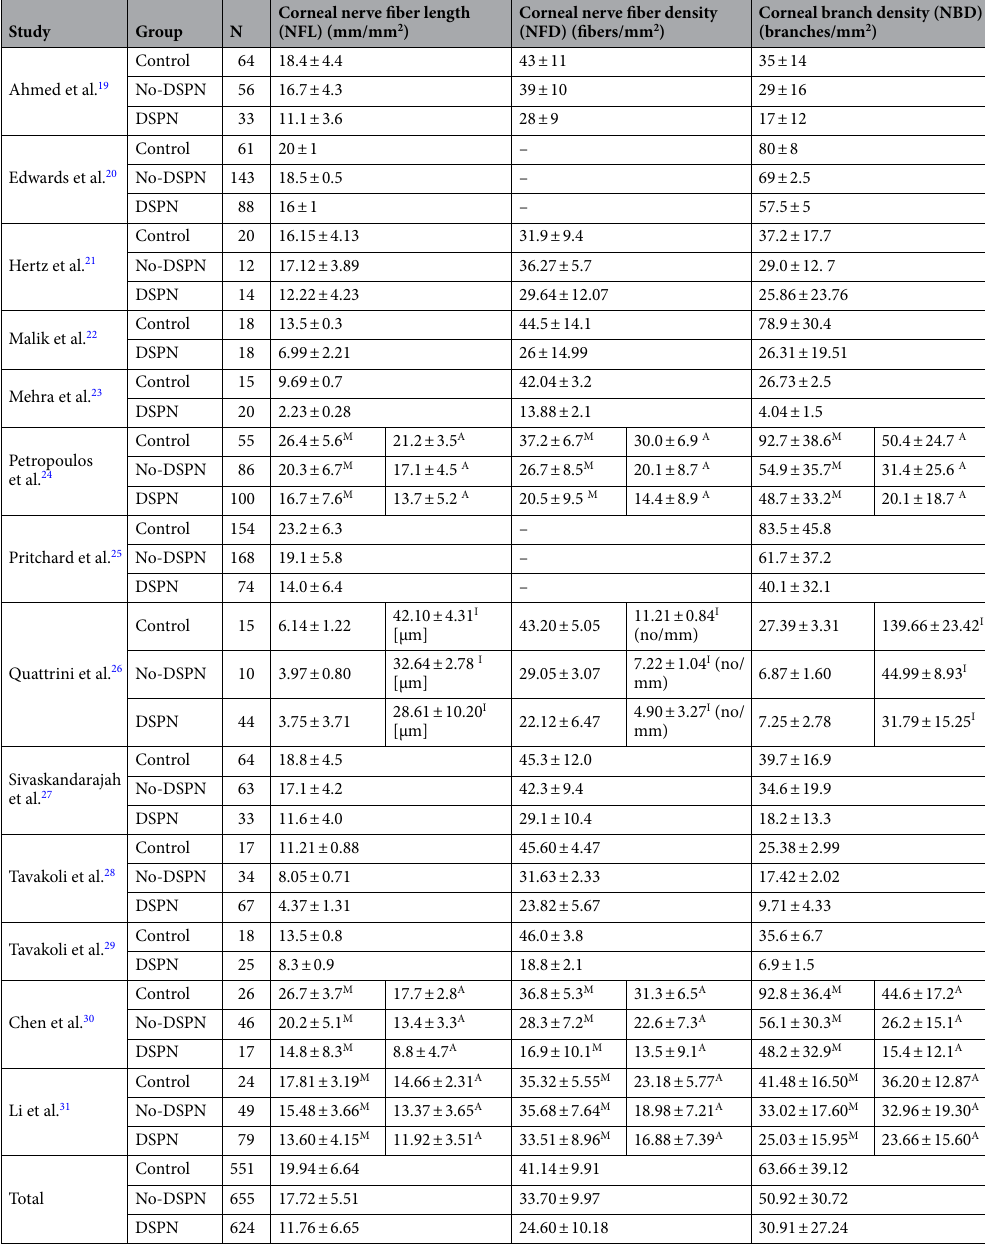
Table 4. CCM Parameter from studies 19–31 . I Intra-epidermal nerve fiber (IENF). A Automated IVCCM. M Manual IVCCM; IVCCM: in vivo